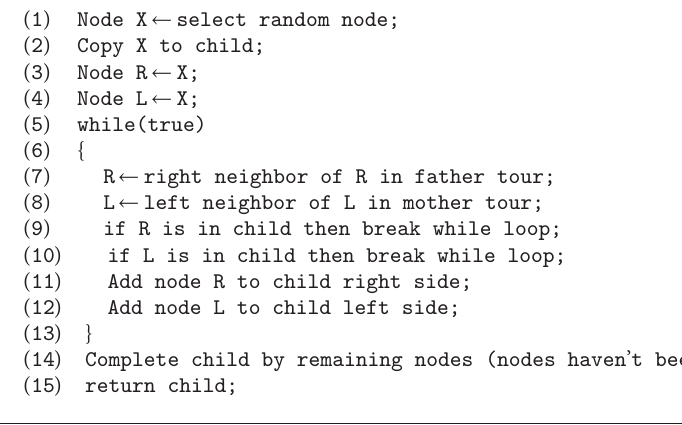
Algorithm 5: Pseudocodes for GSX-0.